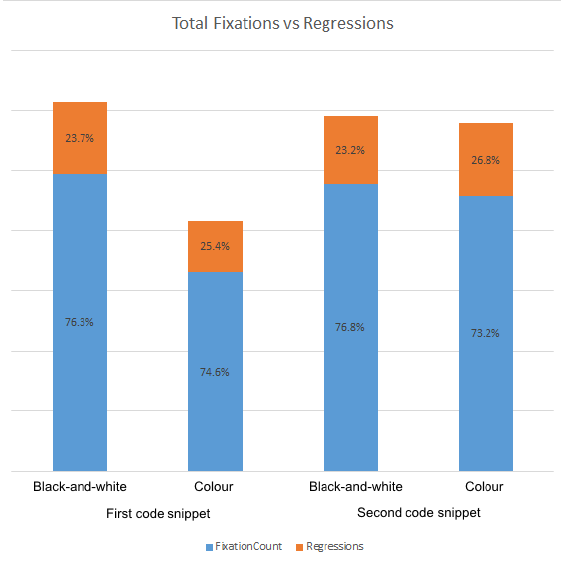
Figure 6. Fixations (blue bar) vs regressive fixations (orange bar) expressed as a percentage of total fixations for all code